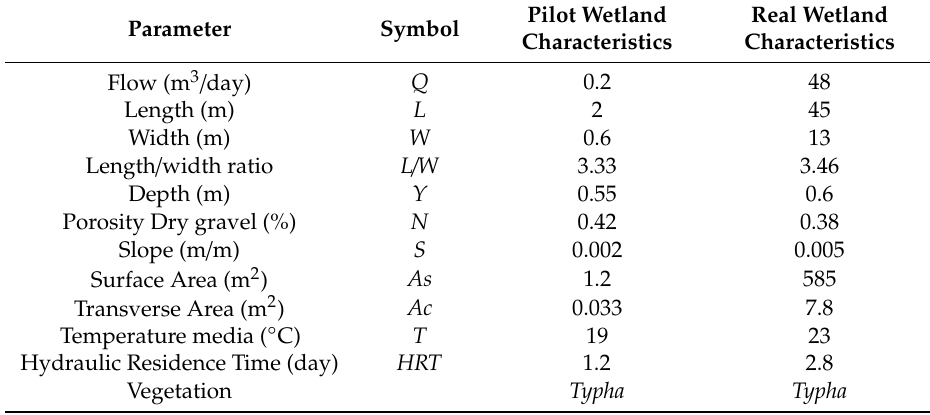
Figure 3. Wetlands of horizontal subsurface flow. ( Left ) Pilot wetlands, located in dependencies of the University of Bío Bío, Concepción. ( Right ) Real-scale wetland, located in the Recreational Center Ainahue, Hualqui. Table 2. Dimensions of wetland subsurface horizontal flow. Physical–chemical parameters and analytical methods.